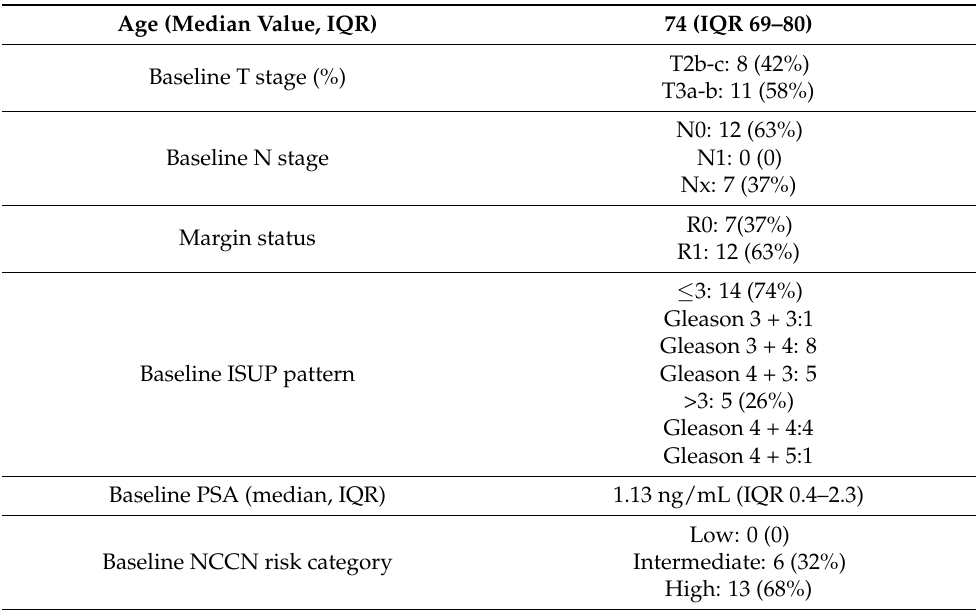
Table 2. Principal baseline features of included